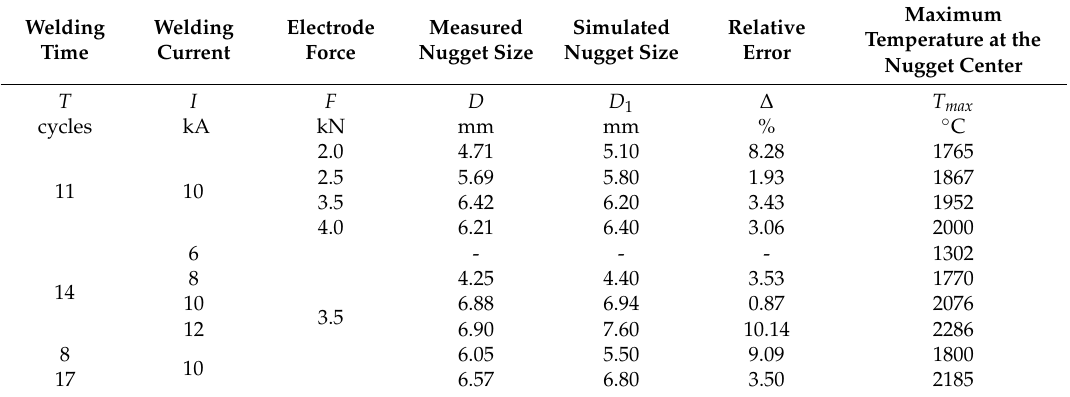
Table 4. Comparison of simulated results and experimental